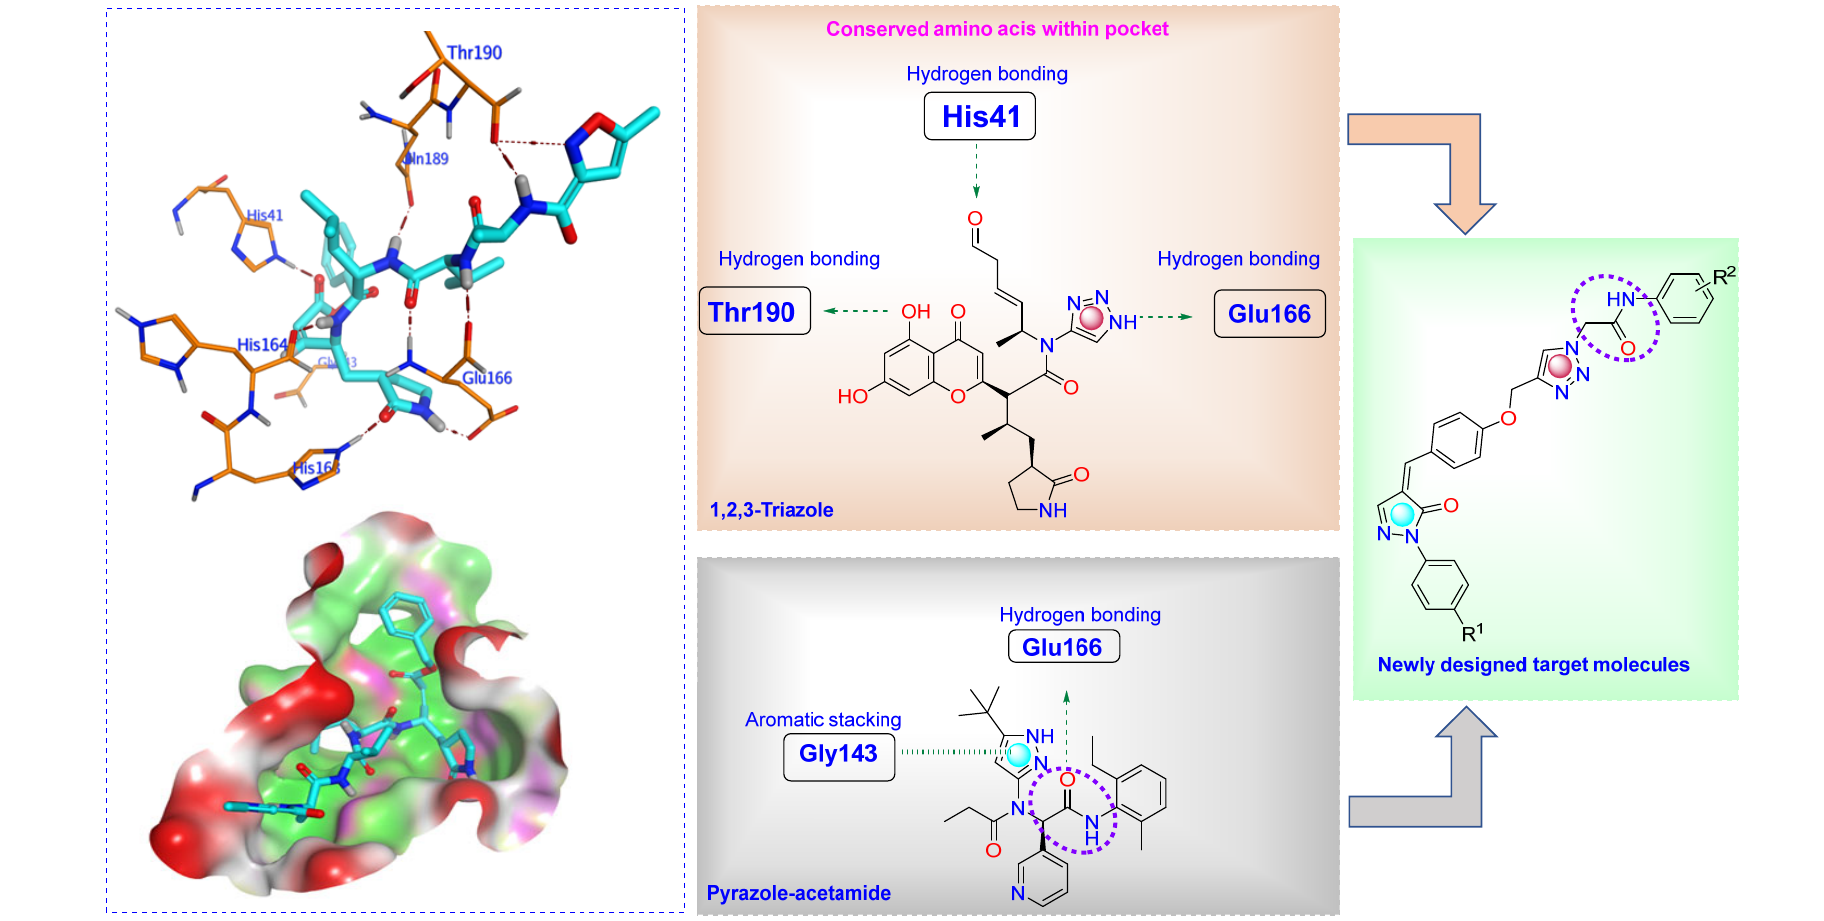
Figure 3. Strategy design of target molecules.